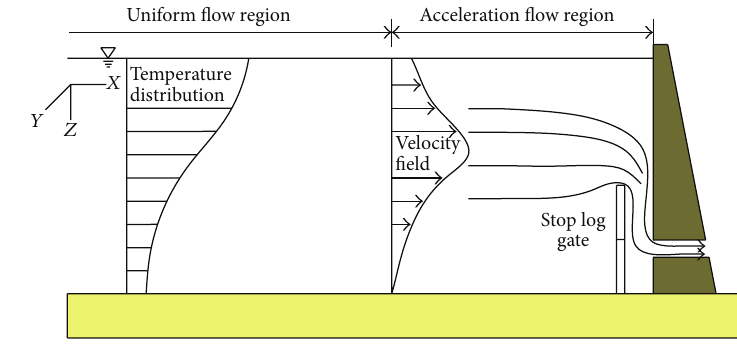
Figure 1: Flow regions in the reservoir.